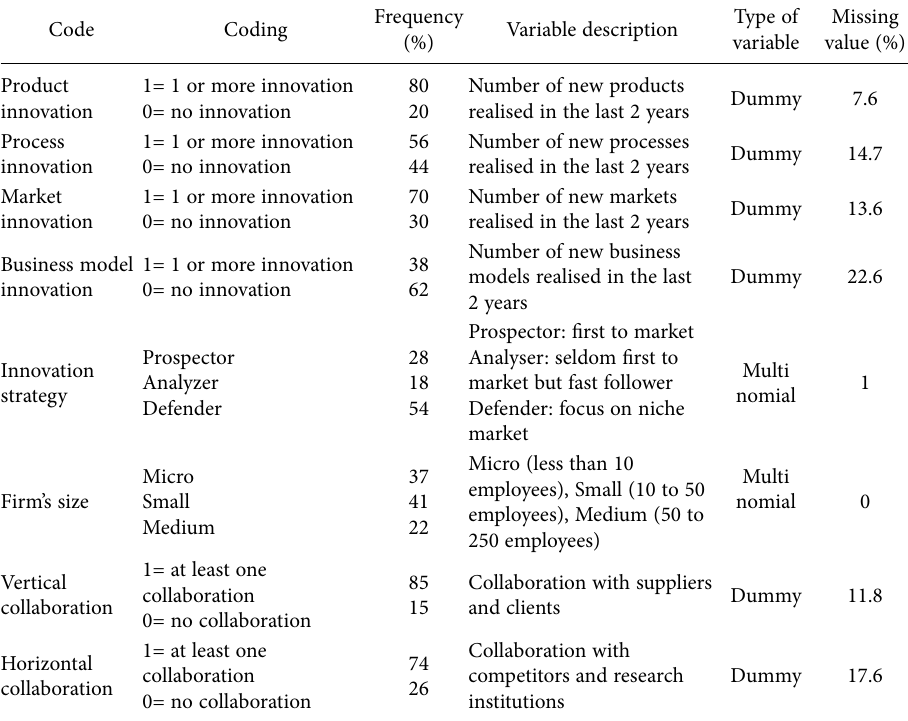
Table 2. List of variables used in the classification tree analysis.